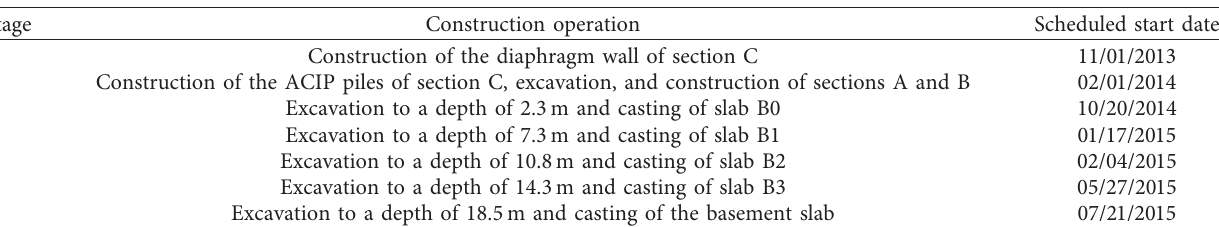
Figure 2: Surrounding environment of foundation pit. Table 1: Main construction